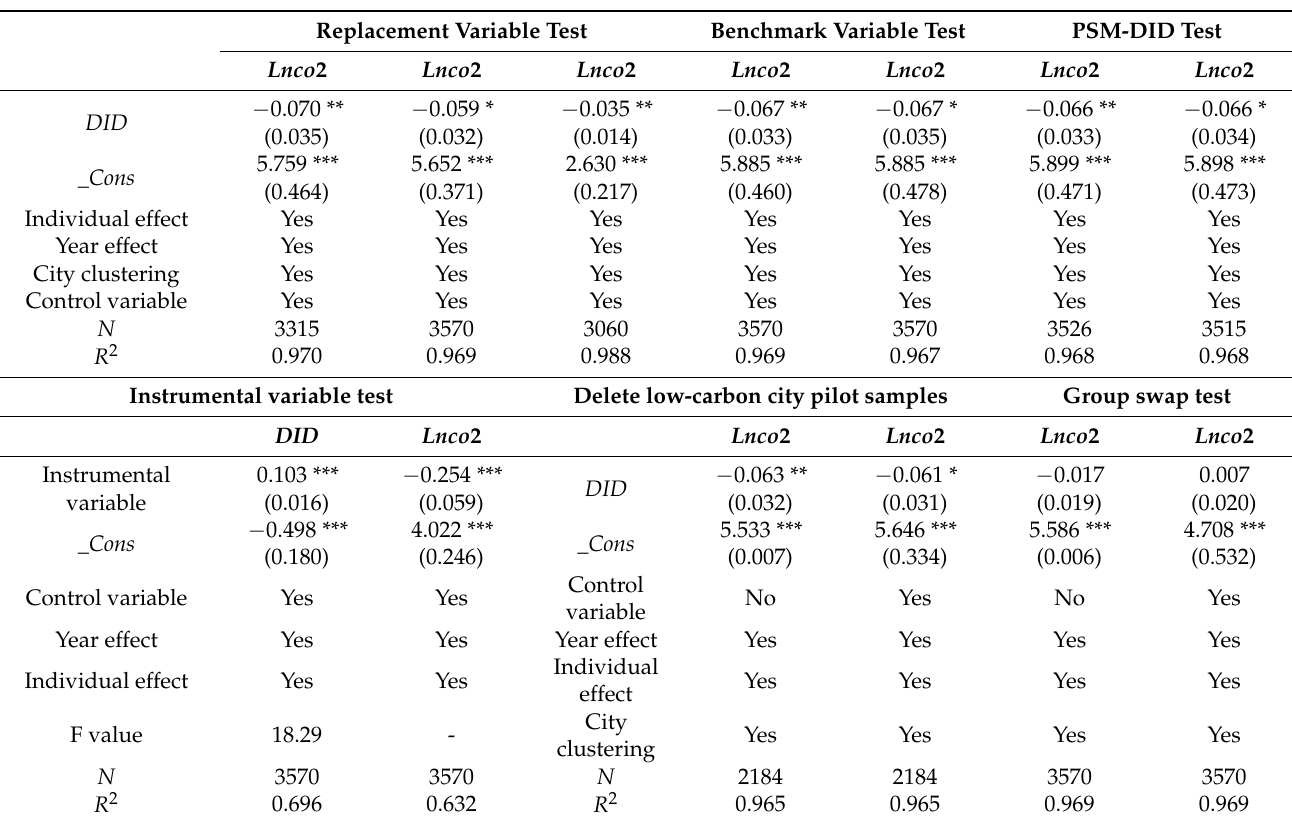
Table 3. Robustness test. Replacement Variable